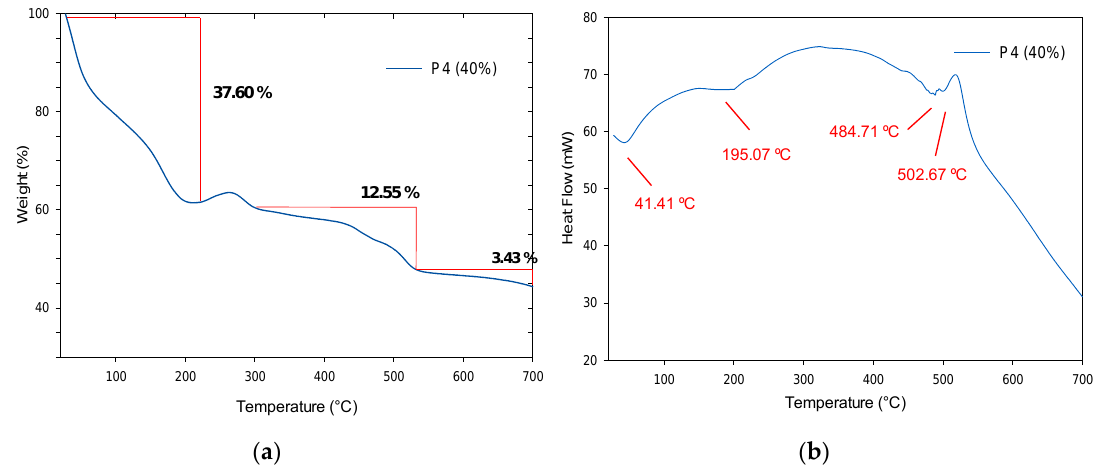
Figure 21. P4 (40%) results: ( a ) TGA analysis and ( b ) DTG thermogram.